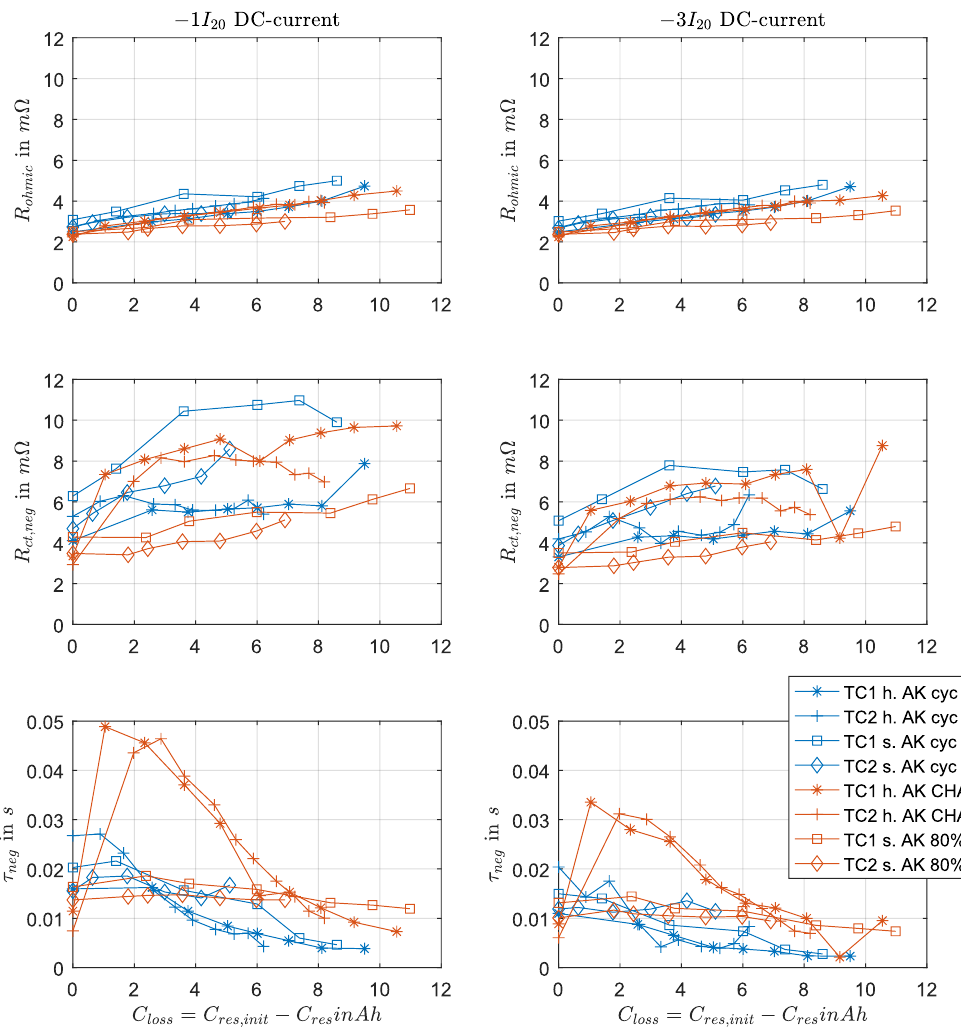
Figure 11. The fitting results ( R ohmic , R ct , neg , and τ neg ) over C loss of hard AK3.4 (h. AK) and soft AK3.4 (s. AK) for both pre-histories, after cycling (cyc) and after charging (CHA and 80%) measured with − 1I 20 and − 3I 20 . The test cells are distinguished by different marks and the pre-history by different